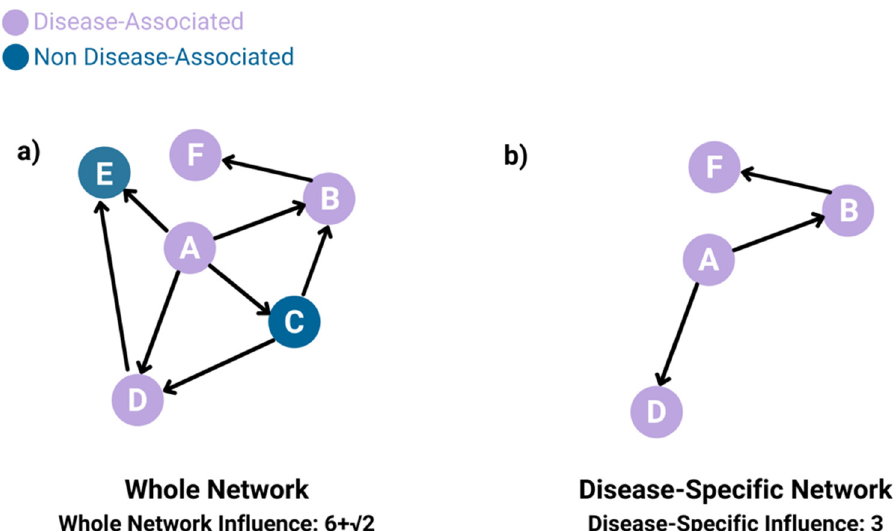
Figure 2. Whole-network influence uses I() on the Consensus Influence Network, while disease- specific influence uses I() on the Disease-Specific Network, with I() described in Algorithm 1. ( a ) Calculation of whole-network influence for node A. Node A has four children, which is raised to the power of 1. Node B and Node D each have one child, which is raised to the power of ½. Node C has two children, which is also raised to the power of ½. This gives a total whole-network influence of 6 + √ 2 for node A’s whole-network influence. ( b ) Calculation of disease-specific influence for node A. The Disease-Specific Network is created by removing all the nodes that are not disease-associated and their incident edges. Node A has two children, and Node B has one child. This gives a total disease-specific network example of 3.